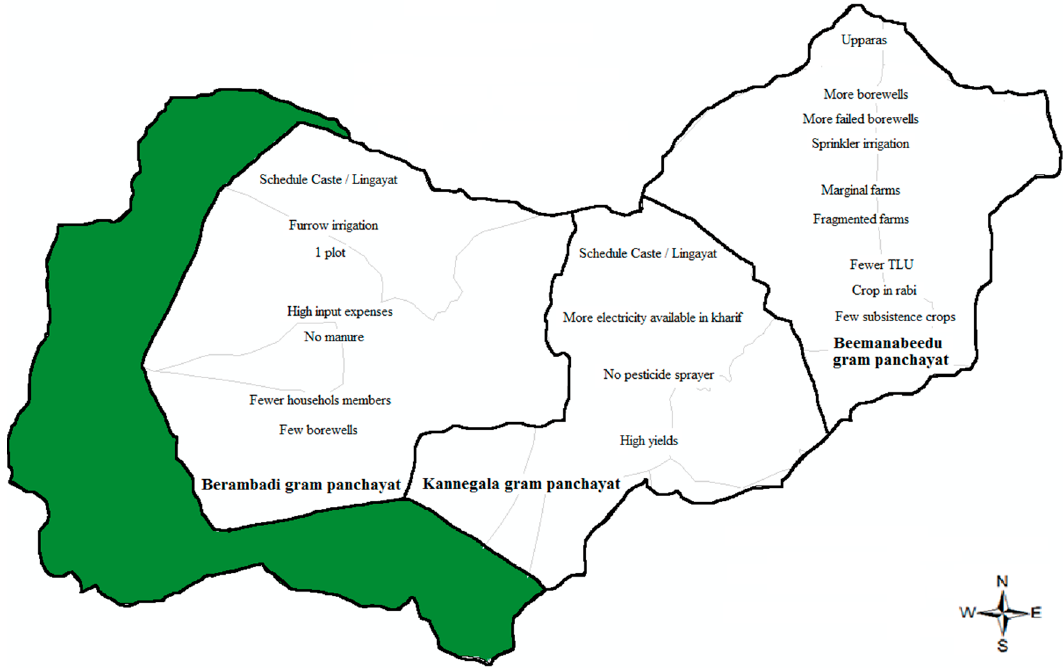
Figure 2. Spatialization of statistically different farm characteristics on the watershed. Black lines refer to gram panchayat borders, grey lines refer to village borders, green area describes the forest.